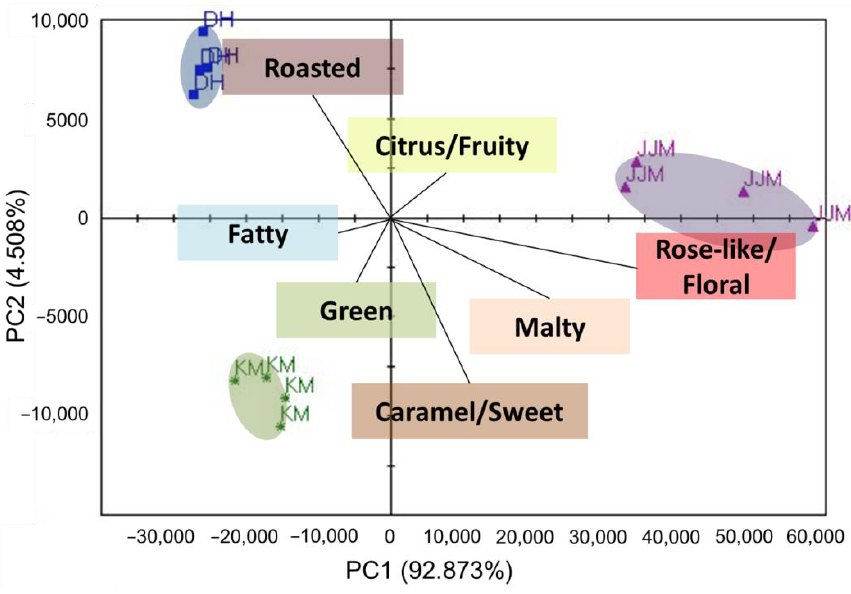
Figure 1. Principal component analysis and sensory analysis of three black